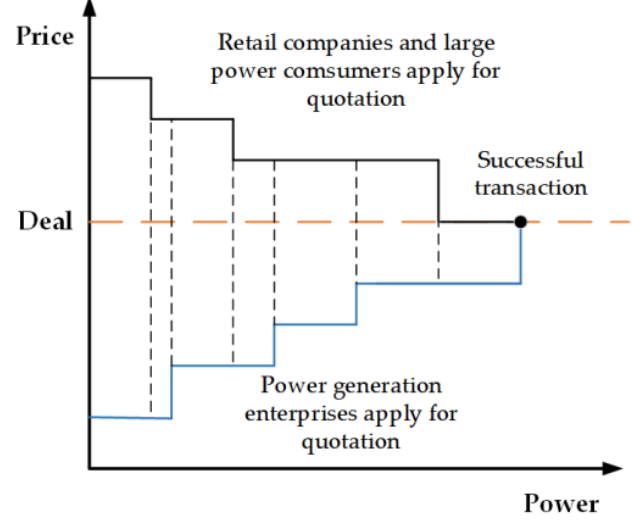
Figure 1. Schematic diagram of monthly centralized bidding quotation.